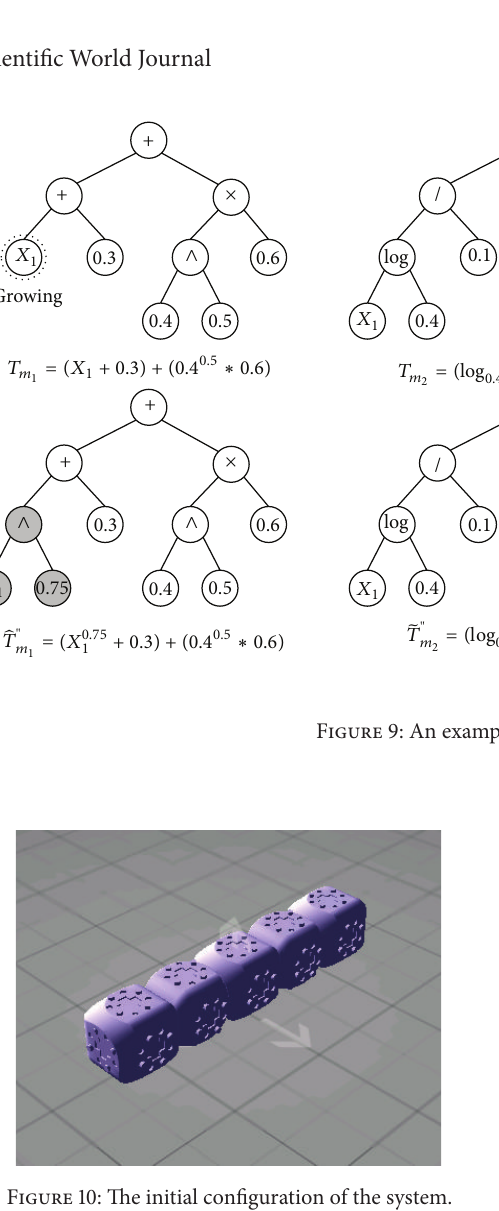
Figure 10: The initial configuration of the